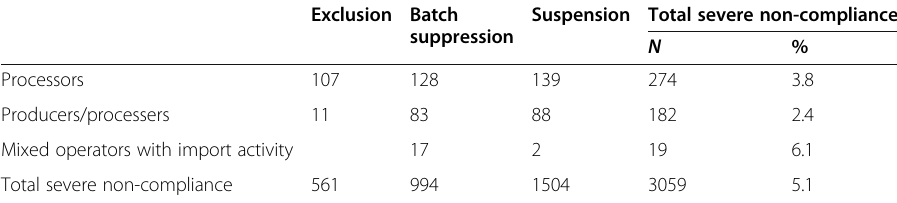
Table 4 Number of sanctions by type of infringement and